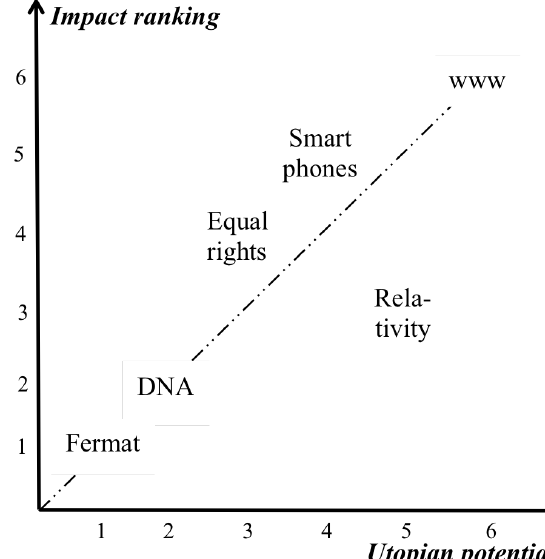
Fig. 5. The graph shows the total impact ranking as a function of the utopian potential ranking (data as in Tables 2 and